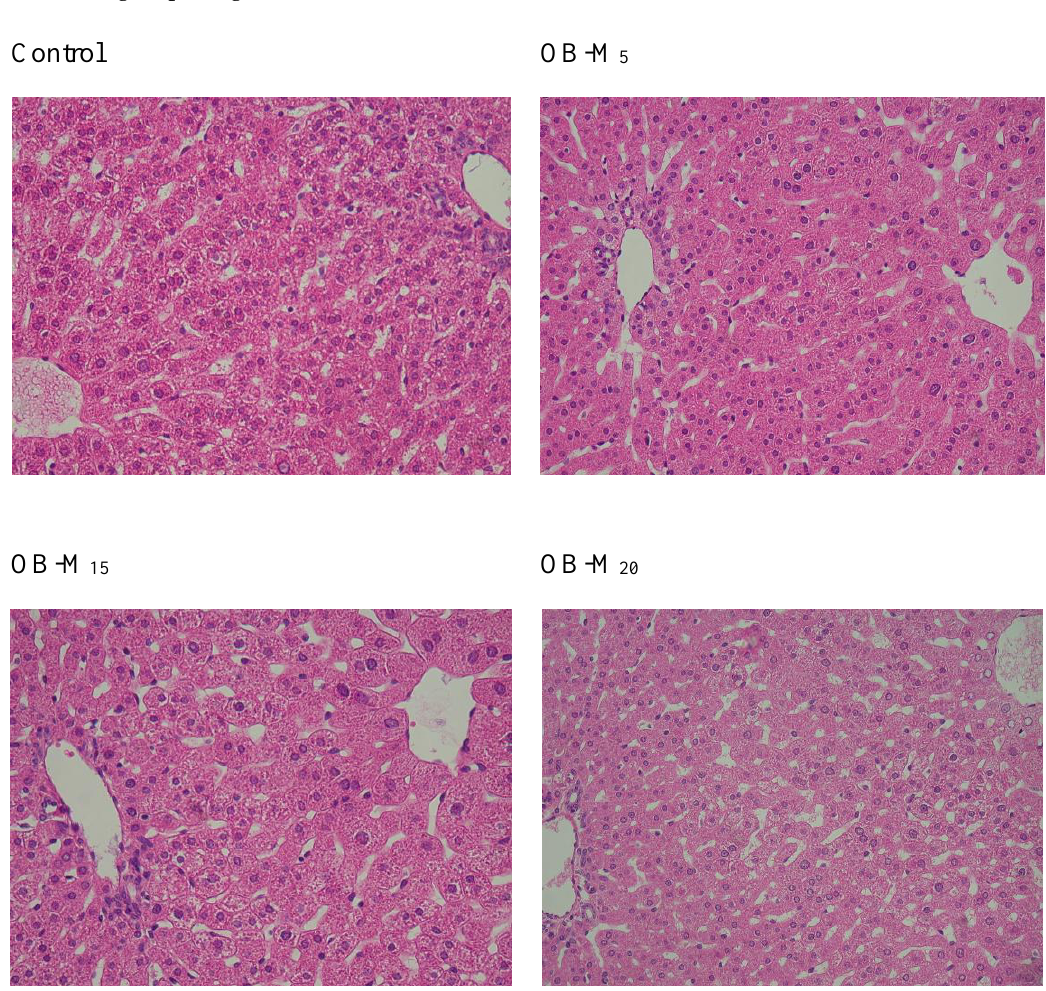
Figure 2. Effects of the experimental oil on the haematoxylin and eosin staining of histologically sectioned liver tissues in hamsters (200X). Control, 5% w / w soybean oil; OB-M 5 , 5% w / w of experimental oil mix; OB-M 15 , 15% w / w of experimental oil mix; OB-M 20 , 20% w / w experimental oil mix.